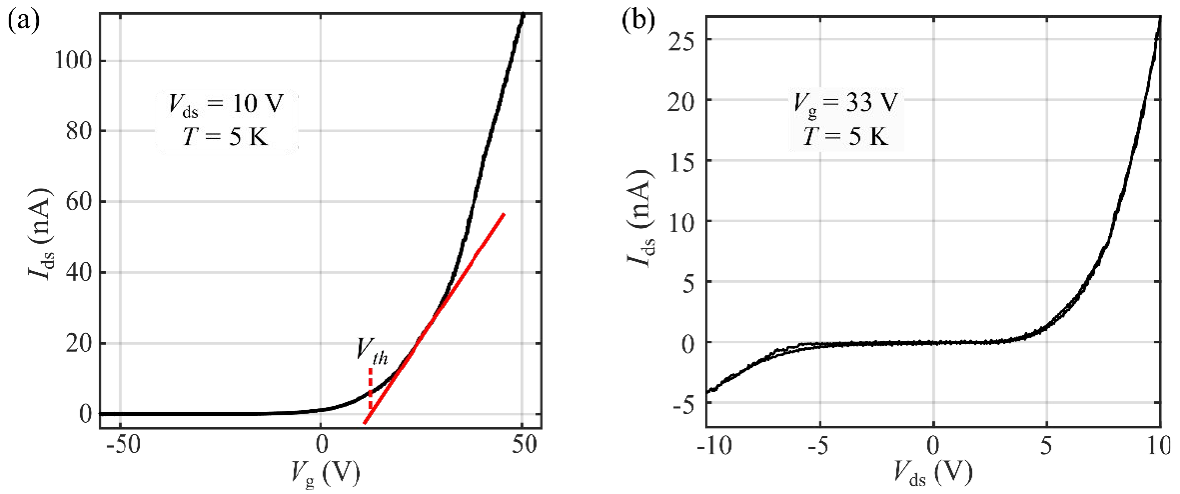
Figure 2. Electronic response and photocurrent spectrum of the device: ( a ) Gate transfer characteris- tics at V ds = 10 V. The threshold gate voltage is estimated by extrapolating the linear region of I ds (red solid line). ( b ) I – V characteristics of the device measured at V g − V th = 20